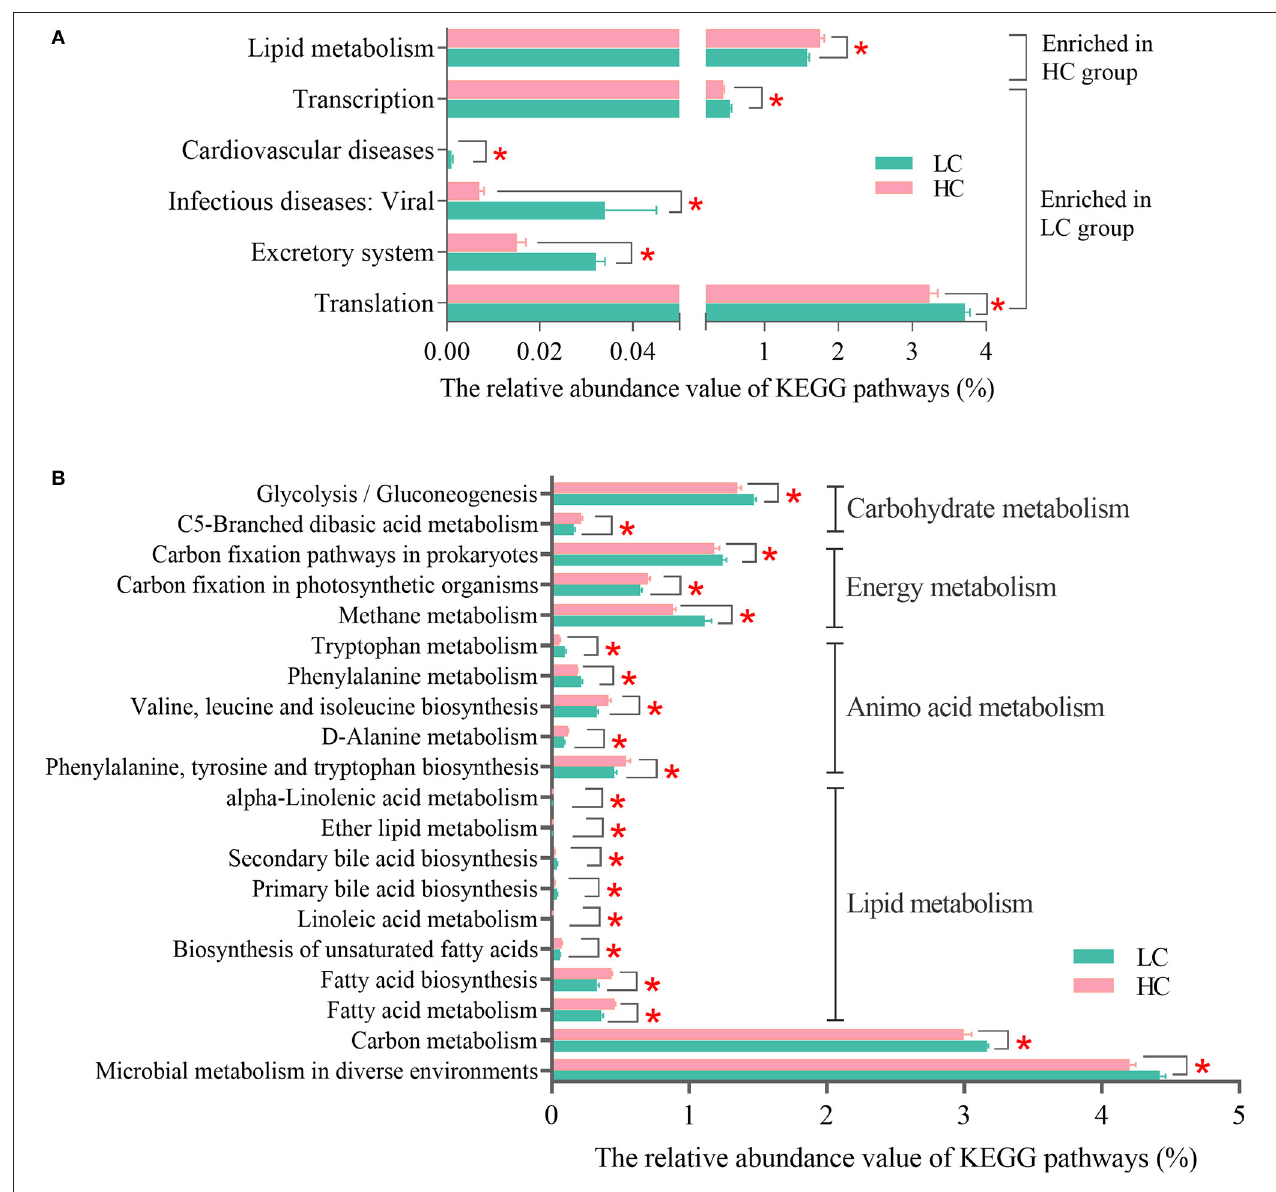
FIGURE 4 | Effects of high-concentrate (HC) diets on KEGG profiles of the fecal microbiota of dairy cows at level 2 (A) and level 3 (B) . KEGG, Kyoto Encyclopedia of Genes and Genomes. * p < 0.05.